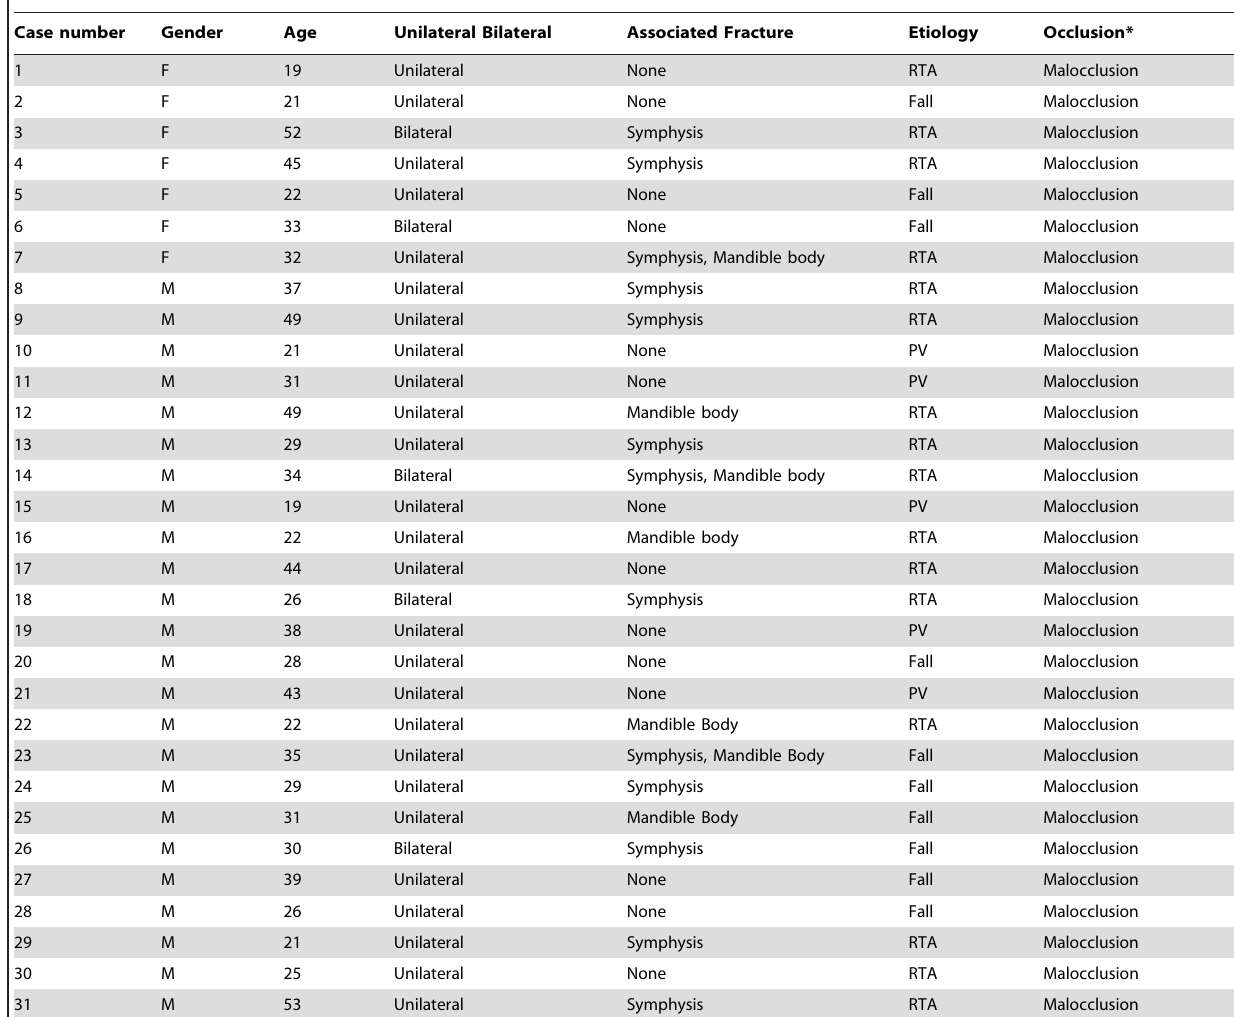
Table 1. Patients’ demographic and clinical